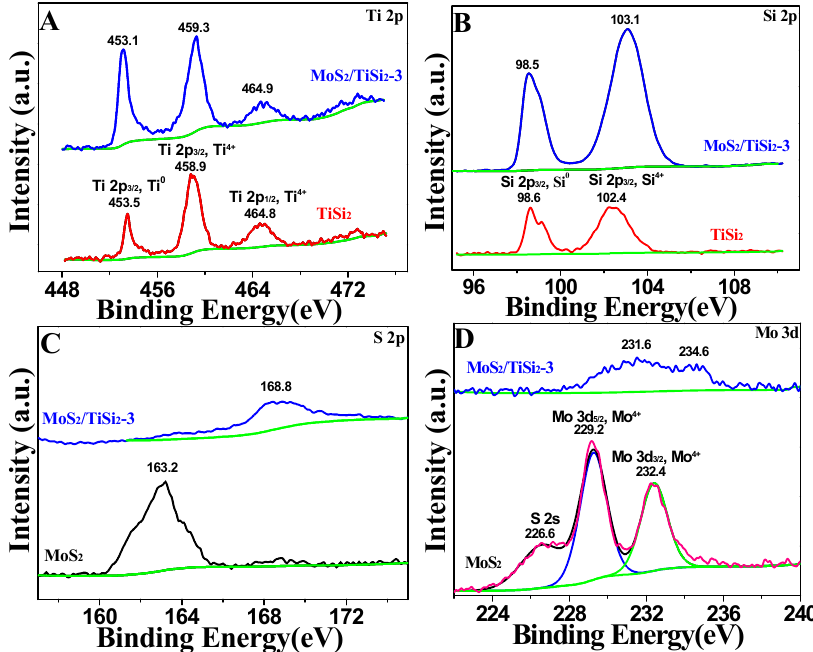
Figure 3. XPS of ( A ) Ti 2p for TiSi 2 and MoS 2 /TiSi 2 -3, ( B ) Si 2p for TiSi 2 and MoS 2 /TiSi 2 -3, ( C ) S 2p for MoS 2 and MoS 2 /TiSi 2 -3, ( D ) Mo 3d for MoS 2 and MoS 2 /TiSi 2 -3.